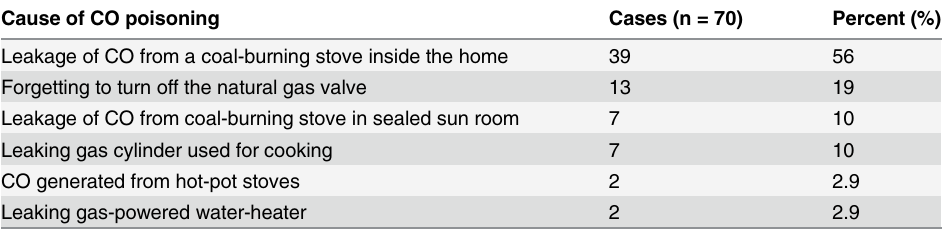
Table 1. Causes of non-occupational carbon monoxide poisoning: Anshan Prefecture, Liaoning Prov- ince, China, October 1, 2010, to February 28, 2011. Cause of CO poisoning Leakage of CO from a coal-burning stove inside the home Forgetting to turn off the natural gas valve Leakage of CO from coal-burning stove in sealed sun room Leaking gas cylinder used for